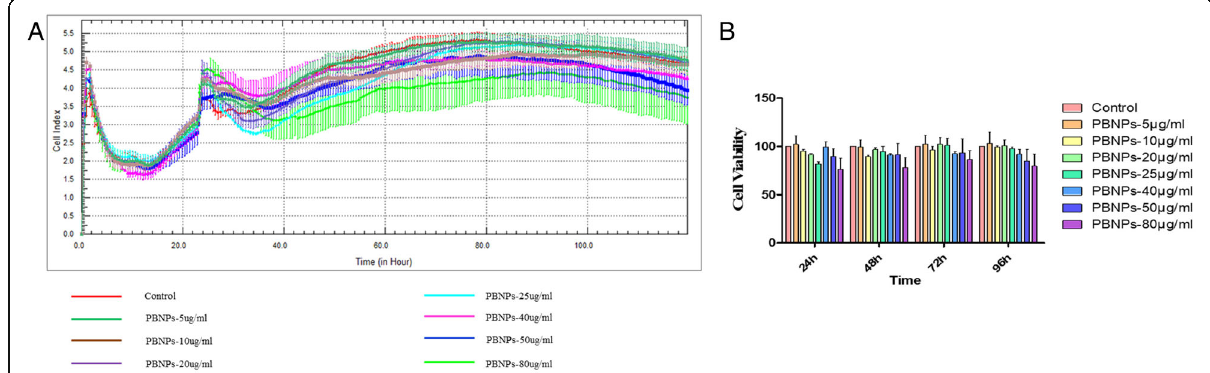
Fig. 4 The proliferation of C3H10T1/2 cells in the presence of various amounts of PBNPs as determined by RT-CIM assay. a The growth curves of C3H10T1/2 cells. b The cell viabilities of C3H10T1/2 cells after treating in 24, 48, 72, and 96 h